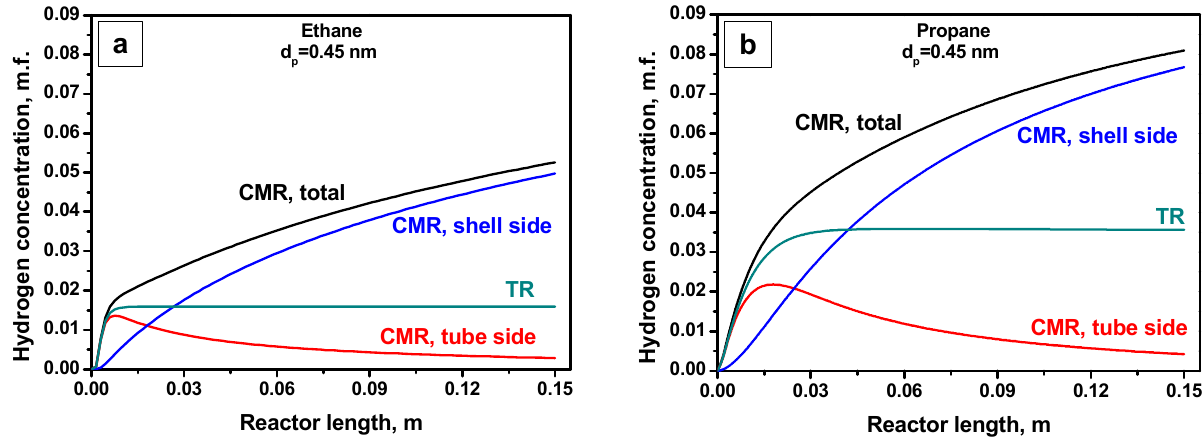
Figure 4. Hydrogen concentrations along the reactor length during the dehydrogenation process in a catalytic membrane reactor ( d p = 0.45 nm) and a tubular reactor: ( a ) ethane dehydrogenation; ( b ) propane dehydrogenation.